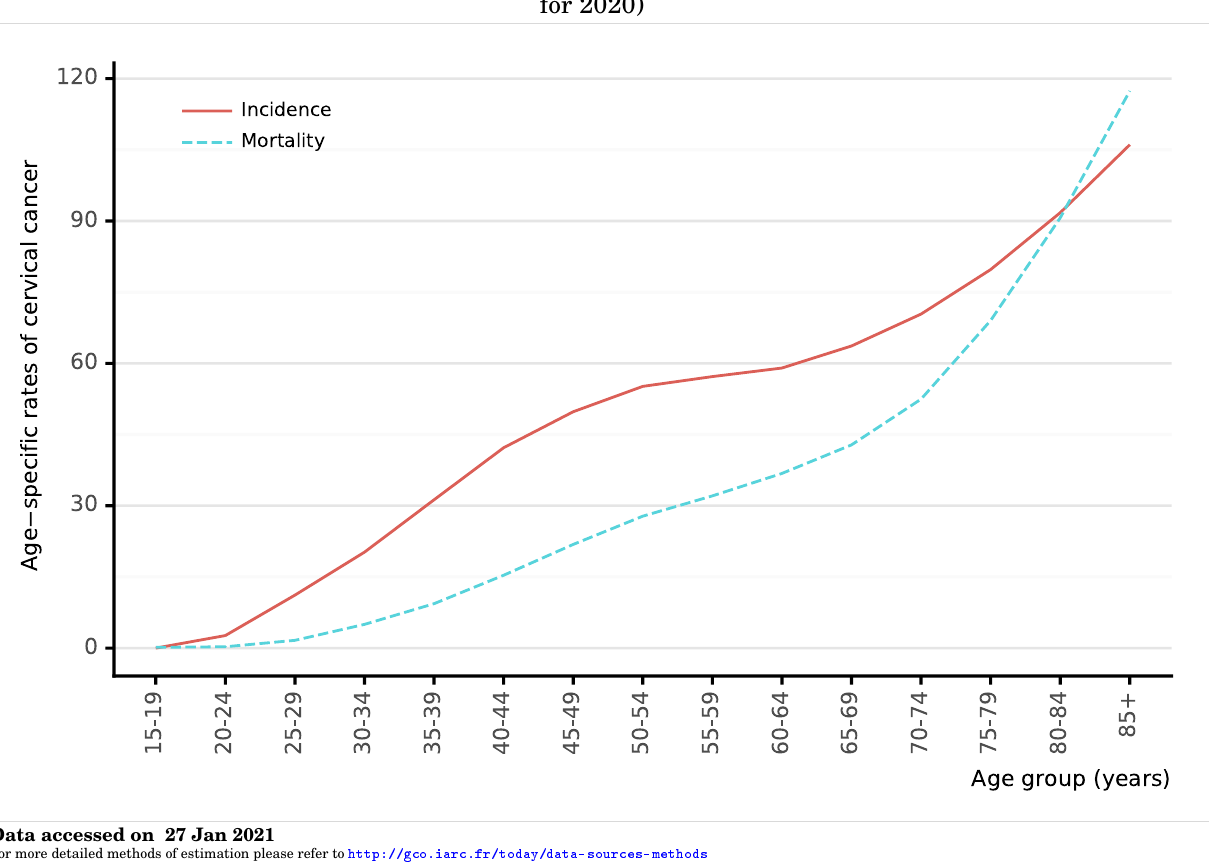
Figure 13: Comparison of age-specific cervical cancer incidence and mortality rates in Peru (estimates